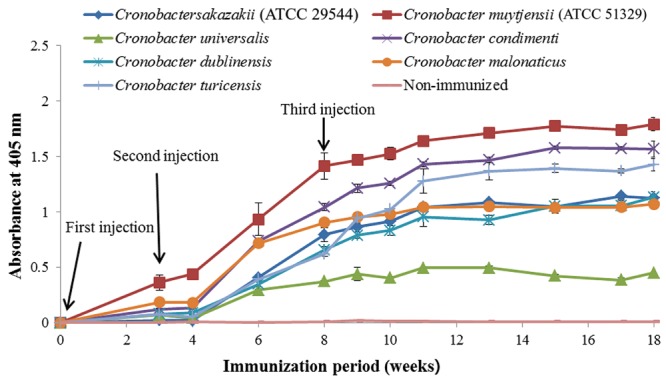
Titers of rabbit anti-serum developed from sonicated cell protein mixture against seven Cronobacter species. All experiments were conducted three times, and data represent mean ± standard deviation.